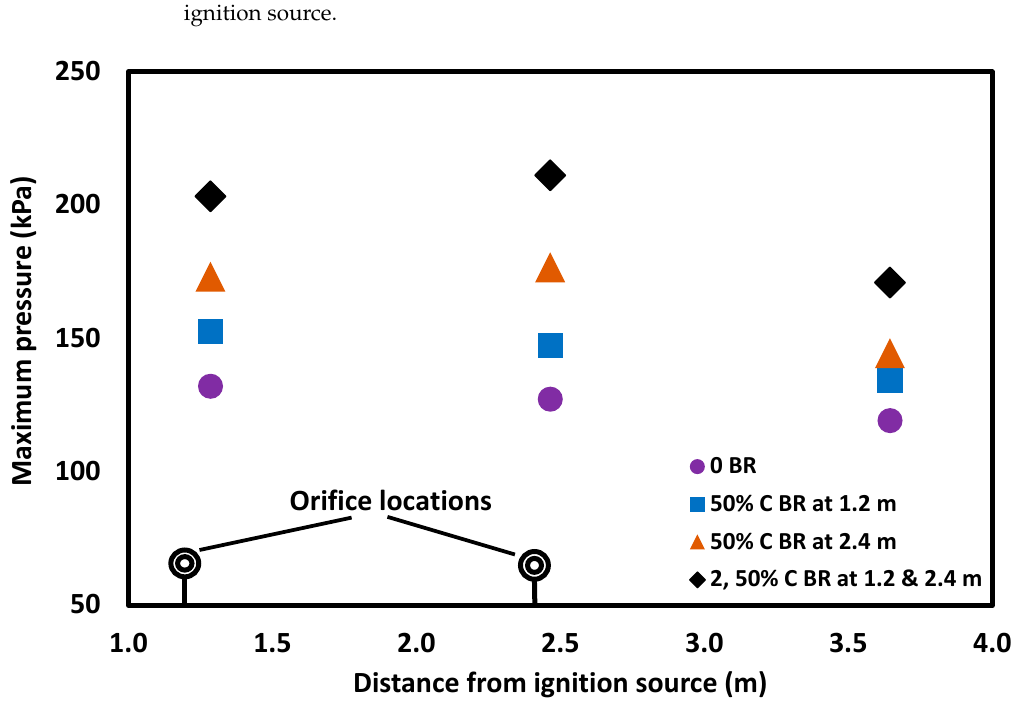
Figure 6. Maximum pressures for 10% methane concentration recorded by three pressure sensors along the length of a straight tube and when the tube included a 50% orifice plate placed 1.2 m or 2.4 m from the ignition source, or two 50% orifice plates placed 1.2 and 2.4 m from the ignition source.